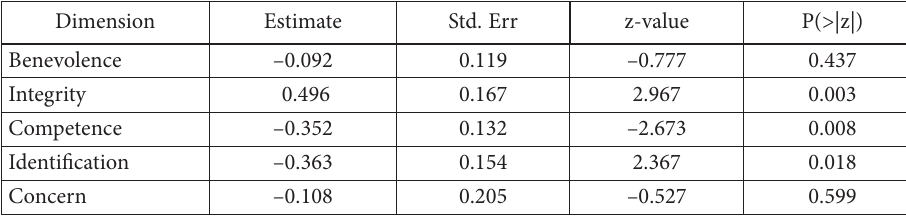
Table 7. Regression analysis results (source: own research)